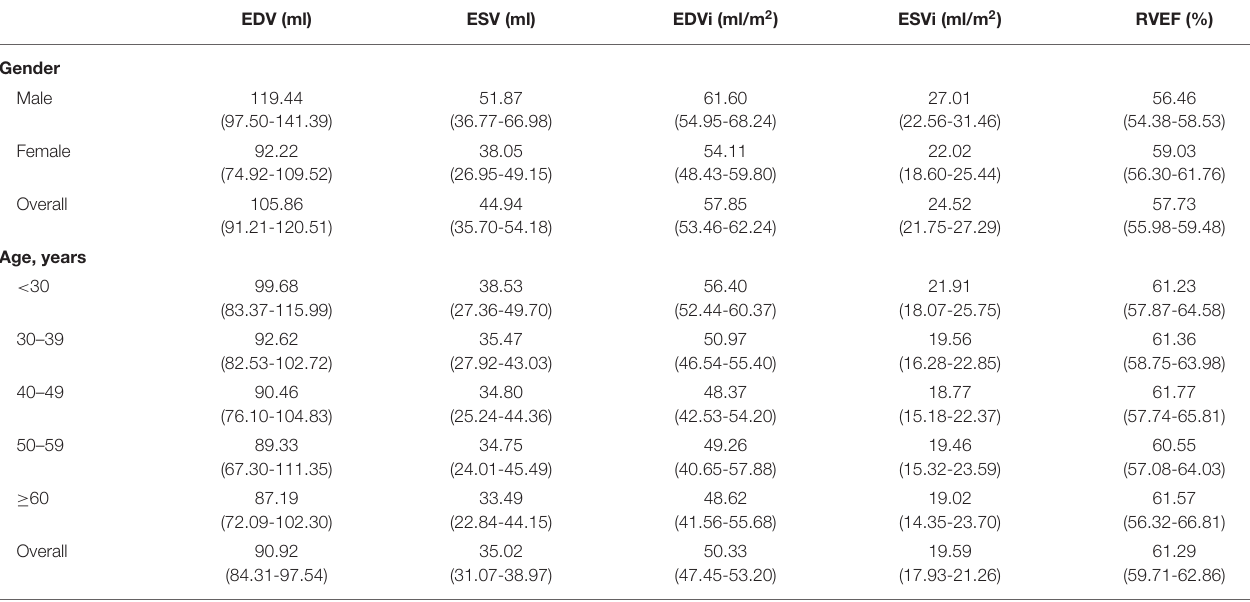
TABLE 4 | Sex- and age-specific reference values of RV volumes and RVEF by